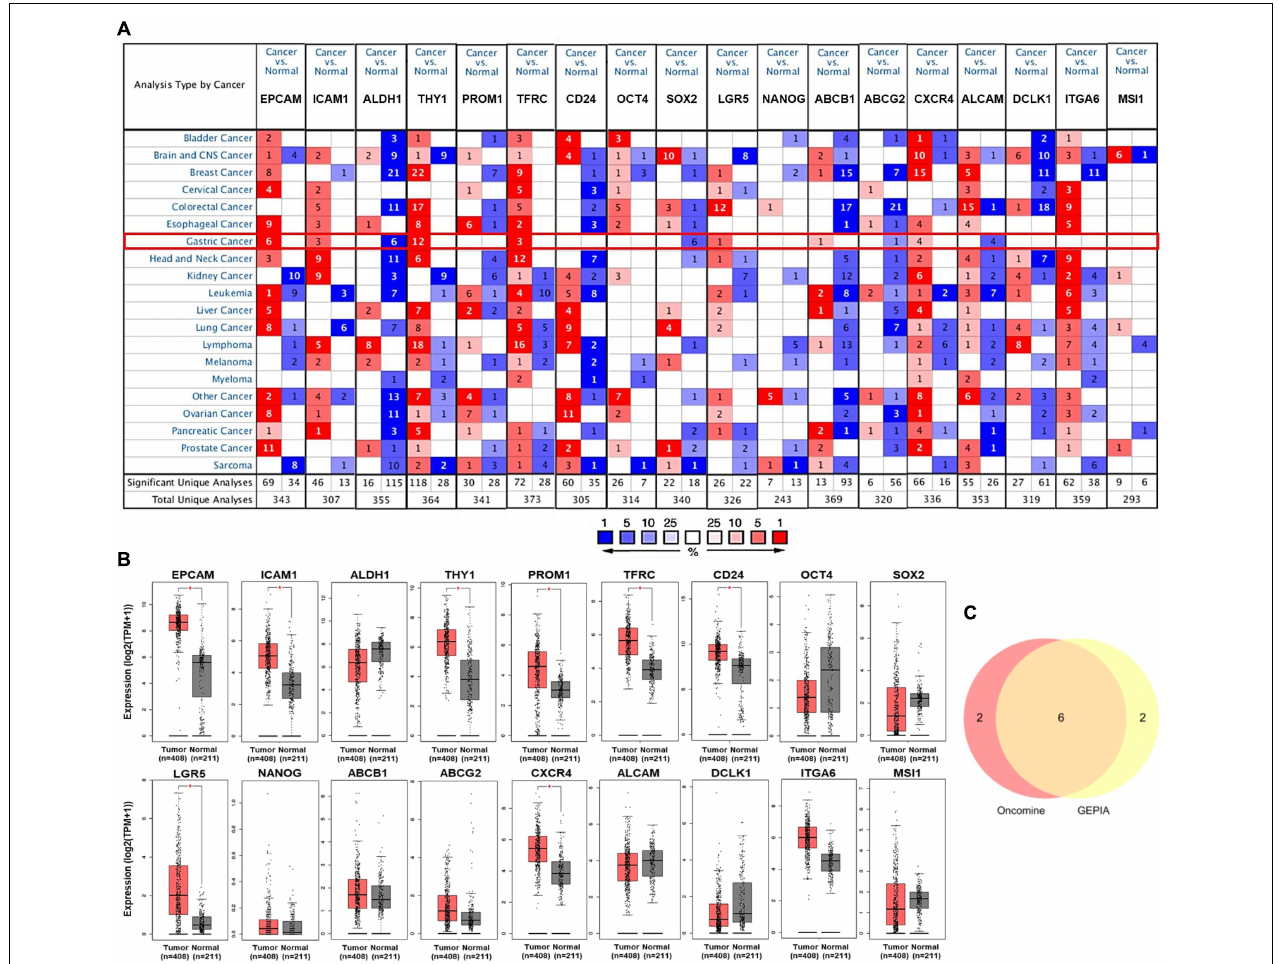
FIGURE 1 | Transcriptional expression of GCSC markers in GC and normal stomach tissues. (A) A summary of the datasets in which GCSC markers were significantly up- (red) or down- (blue) expressed in various cancers, compared with the corresponding normal tissues (Oncomine). Numbers in colored cells represent the counts of datasets. The color depth is paralleled with the median rank of a gene across all the included datasets. (B) Transcriptional expression of GCSC markers in GC and normal stomach tissues (GEPIA). TPM, transcript per million; * P < 0.01. (C) A Venn diagram identified six highly expressed GCSC markers overlapped between Oncomine and GEPIA